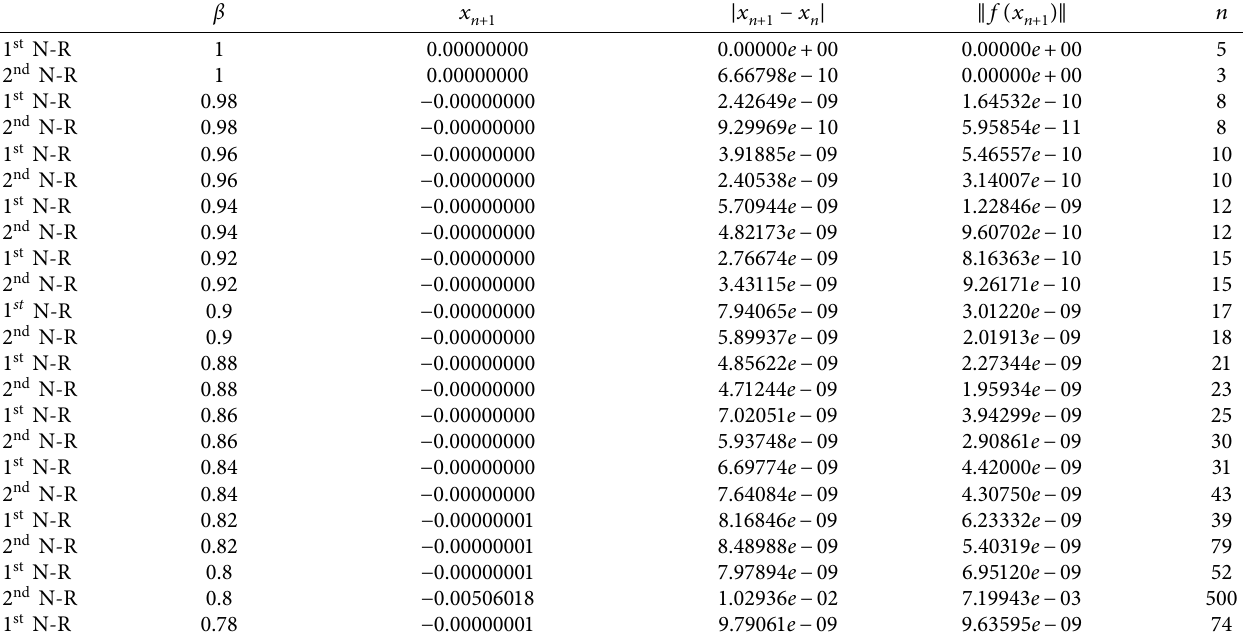
( x ) with Riemann–Liouville derivative and initial estimation x 2